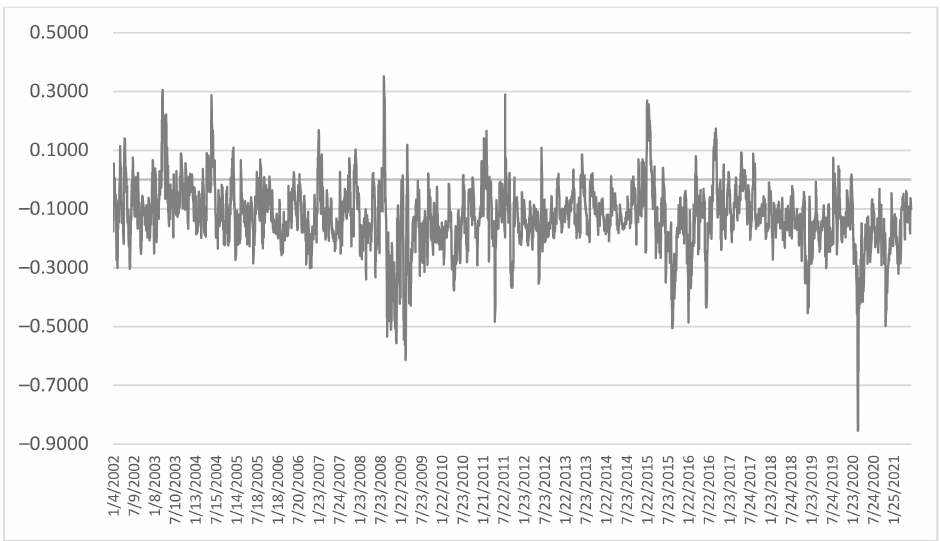
Figure 4. Estimation of the dynamic conditional correlation from model DCC(1,1) GARCH with the multivariate Student’s-t errors, between WTIF and